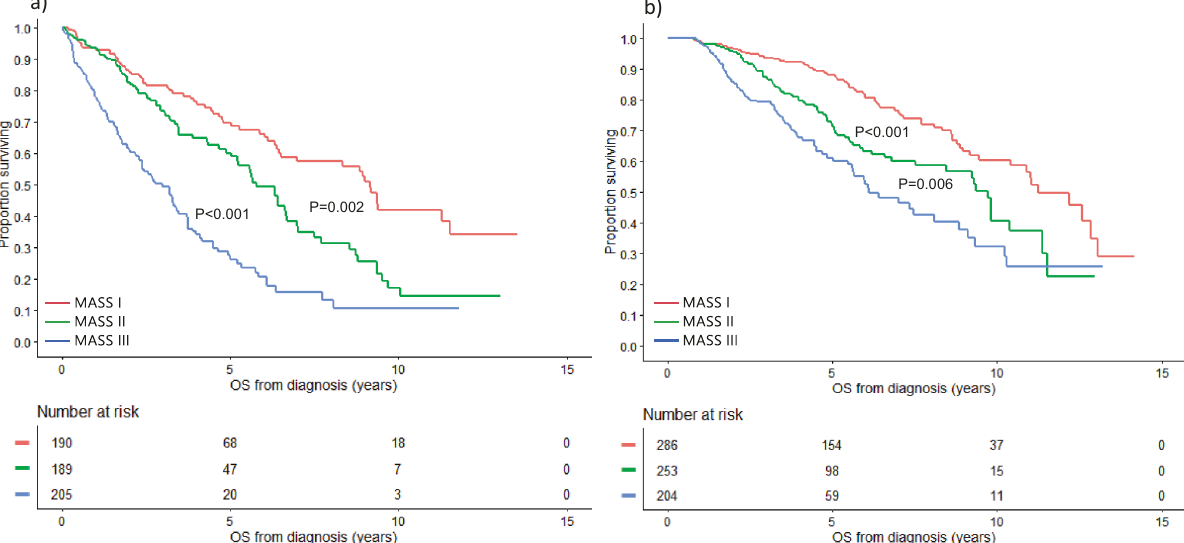
Fig. 4 OS based on the MASS by transplant status. OS (years) in MM patients with MASS I (red curve), MASS II (green curve), and MASS III (blue curve) who ( a ) did not undergo transplant and in those who ( b ) underwent transplant. MASS Mayo Additive Staging System, MM multiple myeloma, OS overall survival. The P values for each pair of groups are presented between the corresponding stage I (no risk factors), stage II (1 risk factor), stage III (2 risk factors), and stage IV ( ≥ 3 risk factors), respectively ( P < 0.001). In the MMRF cohort, OS was 7.8 (95% CI: NR-NR), 6.0 (95% CI: 5.7-NR), 4.6 (95% CI: 3.7 – 5.9), and 1.6 (95% CI: 1.1 – 3.7) years in patients with stage I, II, III, and IV disease, respectively ( P < 0.001) (Supplemental Fig. 3). The Harrell ’ s C for the 4-tier MASS was 0.581 (95% CI 0.554 – 0.609). Impact of the number and type of HR cytogenetic abnormalities We evaluated the prognosis based on the number of HR cytogenetic abnormalities (HR IgH translocation, 1q gain/ampli fi - cation, chromosome 17 abnormality (del)17p/monosomy 17, and MYC rearrangement), excluding non-cytogenetic HR parameters of